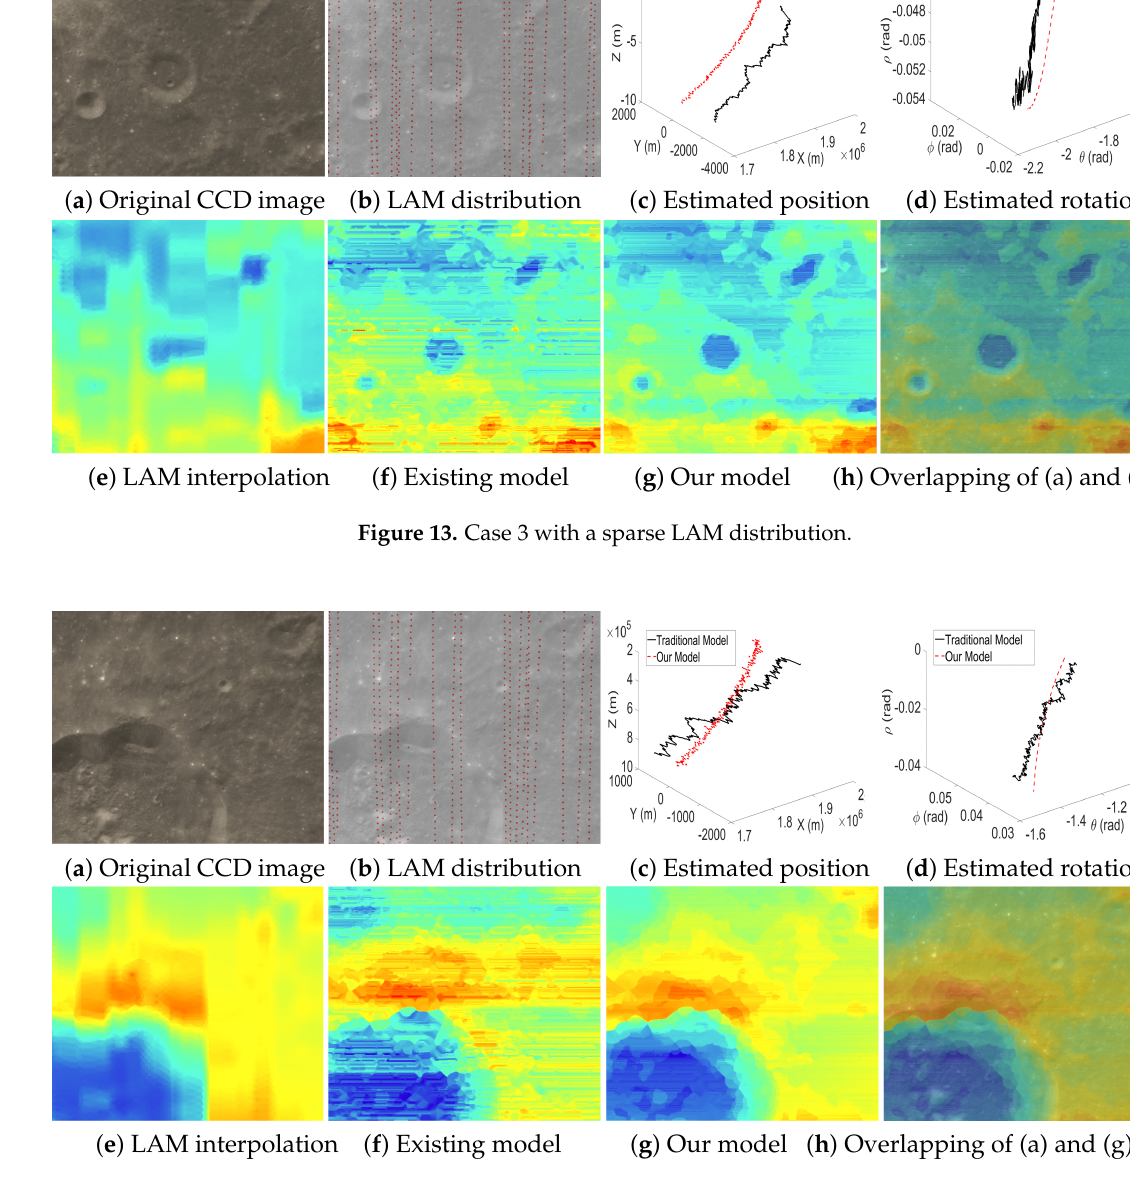
Figure 14. Case 4 with a sparse LAM